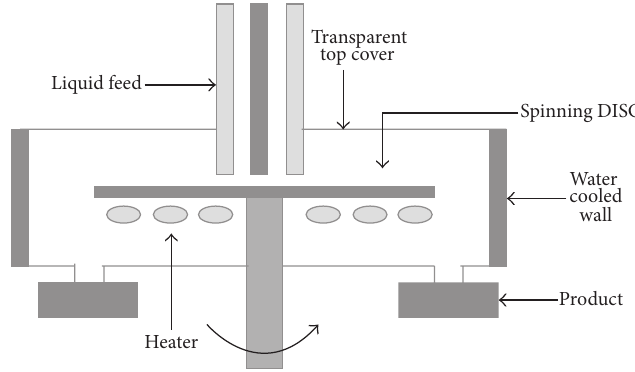
Figure 2: Scheme of the adopted rotating disk reactor [21,